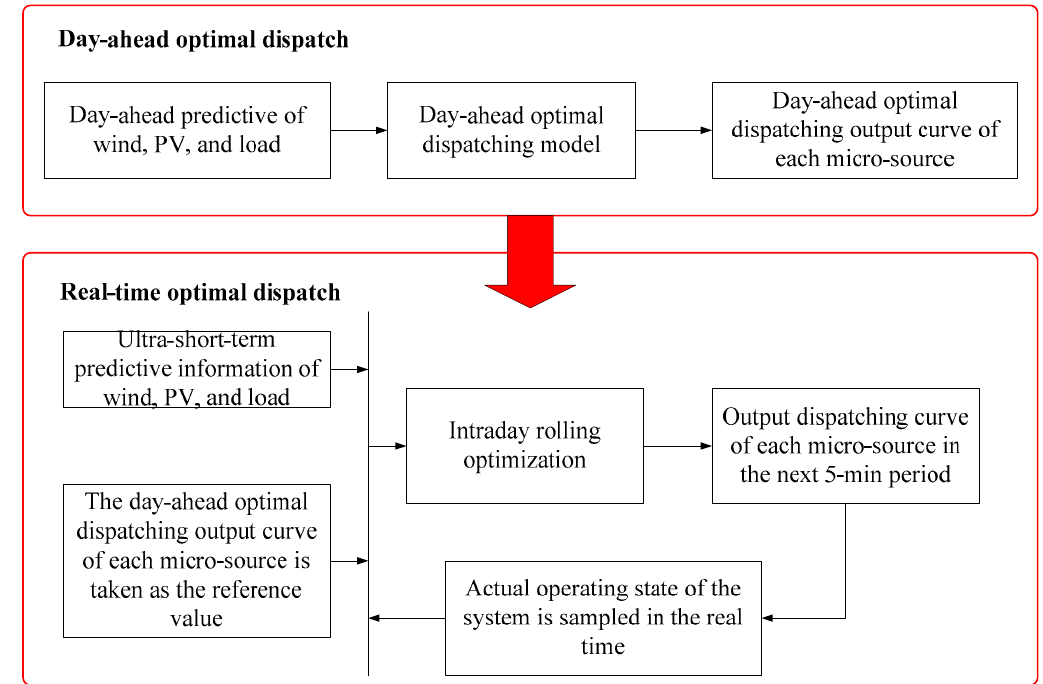
Figure 3. Integrated optimal dispatching framework of the rural micro-energy-grid.